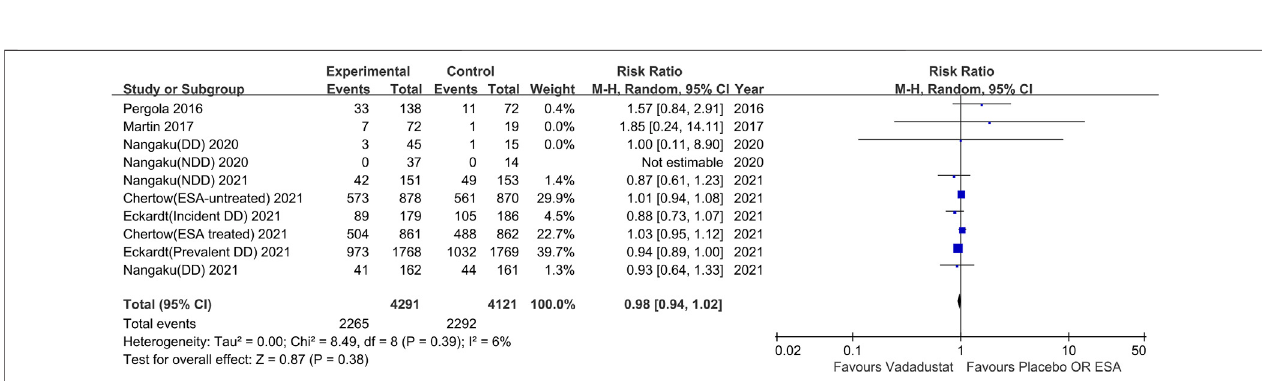
FIGURE 5 | Serious adverse events with vadadustat versus placebo or darbepoetin alfa. The registration number of Nangaku (NDD) 2020 corresponds to NCT03054337; Nangaku (DD)2020 corresponds to NCT03054350, Chertow (ESA-untreated) 2021 corresponds to NCT02648347, Chertow (ESA treated) 2021 corresponds to NCT02680574, Eckardt (incident DD)2021 corresponds to NCT02865850, Eckardt (prevalent DD) 2021 corresponds to NCT02892149, Nangaku (NDD) 2021 corresponds to NCT03329196, Nangaku (DD) 2021 corresponds to NCT03439137.